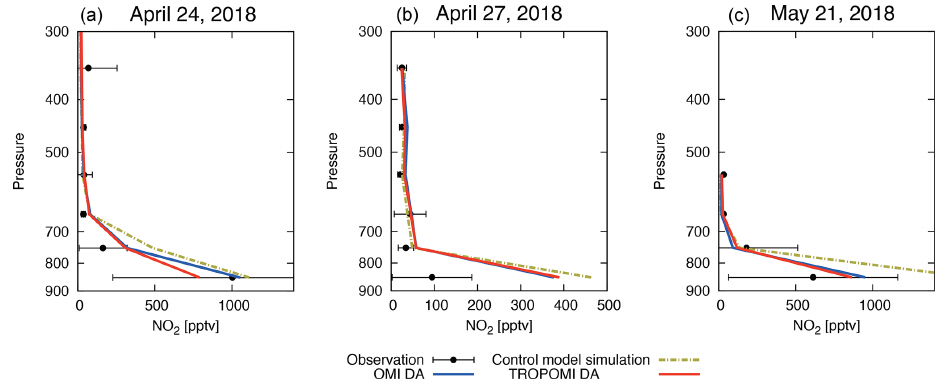
Figure 4. Vertical profiles of NO 2 (pptv) on 24 April (a) , 27 April (b) , and 21 May (c) over coastal areas of the western United States (32– 37 ◦ N, 117.25–122.5 ◦ W). The results were obtained from the ATom-4 aircraft-campaign observations (black), Tropospheric Monitoring Instrument (TROPOMI) data assimilation (DA) (red), Ozone Monitoring Instrument (OMI) DA (blue), and the control model simulation (yellow). The error ranges are the standard deviations of individual values in each pressure